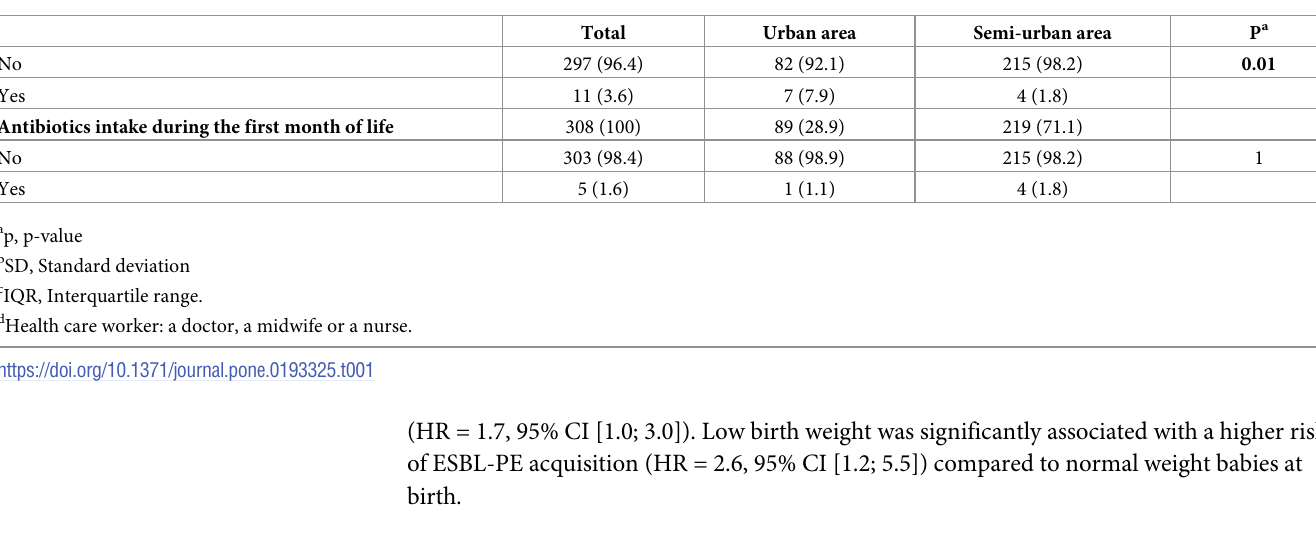
PLOS ONE | https://doi.org/10.1371/journal.pone.0193325 March 1,